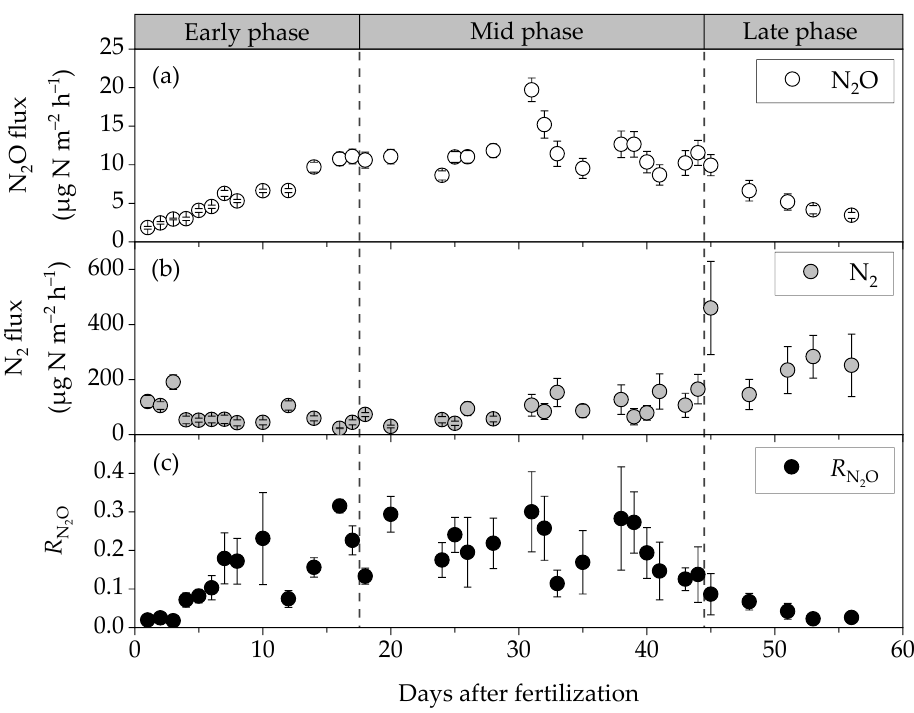
Figure 3. Dynamical ( a ) nitrous oxide (N 2 O) fluxes, ( b ) dinitrogen (N 2 ) fluxes, and ( c ) ratio of N 2 O to N 2 O plus N 2 fluxes ( R N 2 O ) from a black soil following a basal fertilization event of maize. Each vertical bar indicates the standard error of six spatial replicates. The observational period is found in the footnotes of Figure 2.